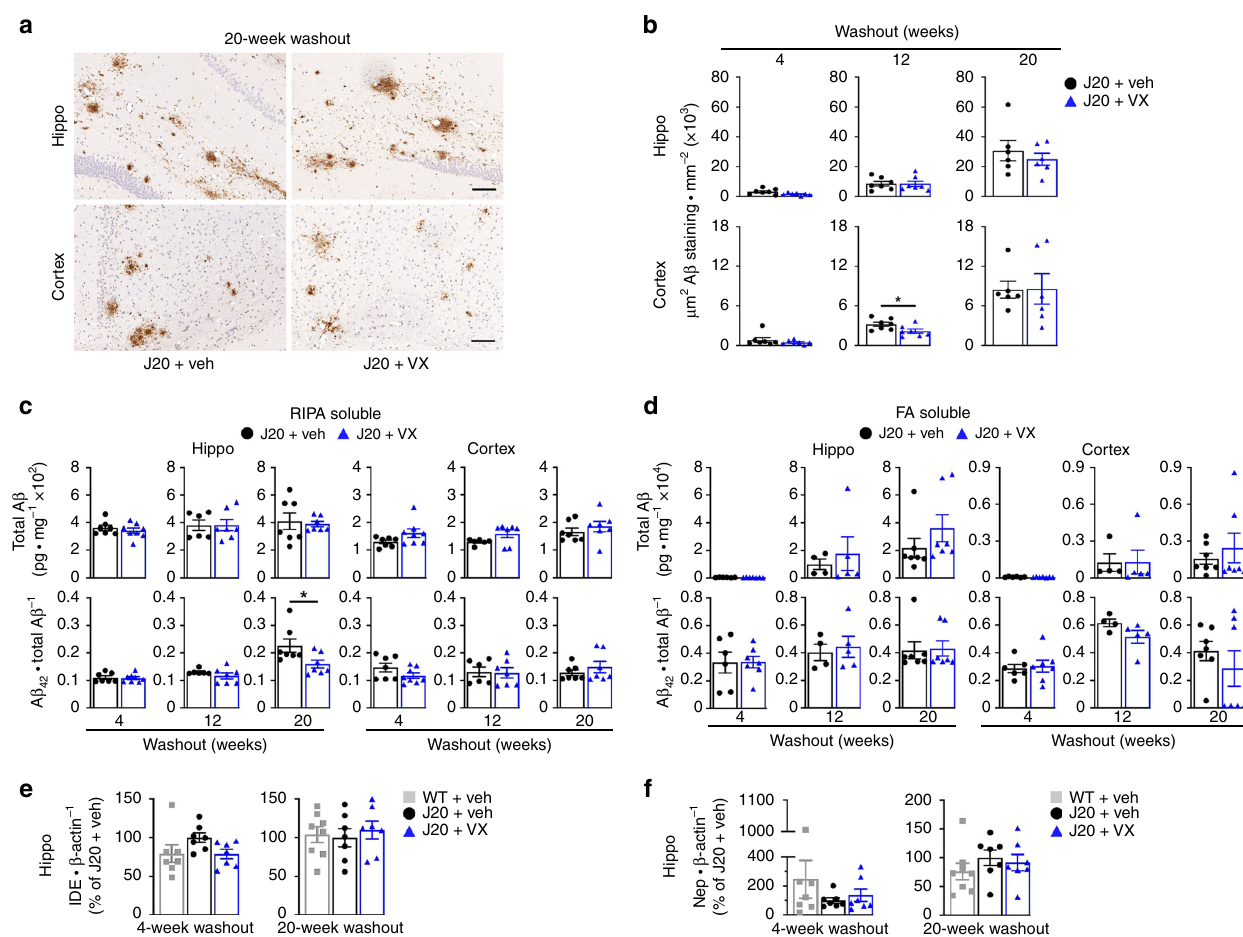
Fig. 6 Pre-symptomatic VX-765 treatment does not affect A β accumulation and deposition. a Representative A β micrographs of hippocampal SLM (top panels) and retrosplenial cortex (bottom panels) in vehicle- and VX-765 treated J20 mice as indicated in ( b ). Scale bar in hippo = 200 μ m, cortex = 50 μ m. b Quantitative analysis comparing A β immunostaining density between vehicle- and VX-765-treated J20 mice in the hippocampal pyramidal cell layer to the SLM and retrosplenial cortex at 4-week ( n = 7 mice per group), 12-week ( n = 7 mice per group) and 20-week ( n = 6 mice per group) WO (cortex 12- week WO, p = 0.0402, two-tailed, unpaired t test). c RIPA-soluble and d FA-soluble total A β levels and A β 42 /total A β ratio in the hippocampus and cortex (A β 42 /total A β hippo 20-week WO, p = 0.0369, two-tailed, unpaired t test). In ( c ), n = 7 J20 + veh and 8 J20 + VX mice at 4-week WO; n = 6 J20 + veh and 7 J20 + VX mice at 12-week WO; n = 7 mice per group at 20-week WO. In ( d ), n = 7 J20 + veh and 8 J20 + VX mice at 4-week WO; n = 4 J20 + veh and 5 J20 + VX at 12-week WO; n = 7 mice per group at 20-week WO. e IDE and f Nep western blot quanti fi cation in the hippocampus at 4- and 20-week WO. In ( e ) and ( f ), n = 7 mice per group at 4-week WO and n = 8 WT + veh, 7 J20 + veh, 7 J20 + VX mice at 20-week WO. Data represents mean and s.e.m. * p <